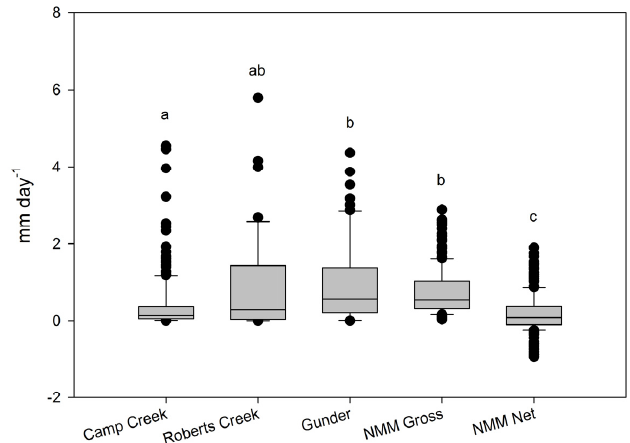
Figure 7. Mean individual pin daily erosion rate (mm day − 1 ) by alluvial unit, NMM Gross, and NMM Net, Walnut Creek, Iowa. Lower-case letters indicate significant difference between units ( p value < 0.05).